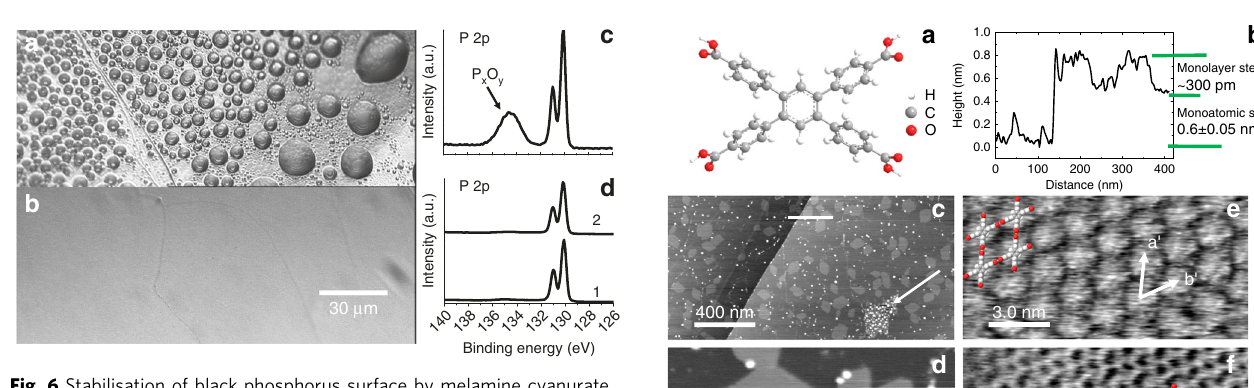
Fig. 6 Stabilisation of black phosphorus surface by melamine cyanurate.